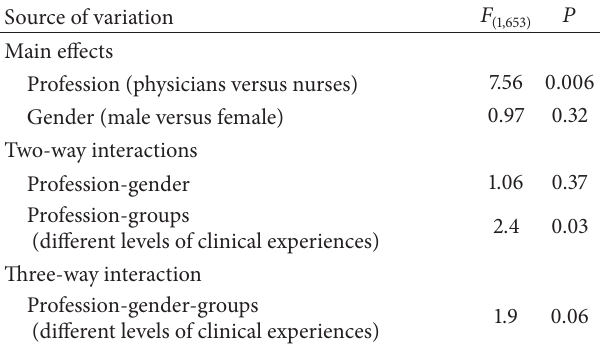
Table 4: Summary results of three-way analysis of variance. Source of